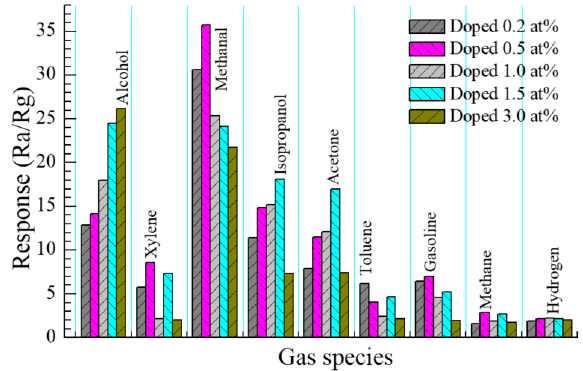
Figure 12. Response of gas sensor based on 0.5 at % Eu-doped SnO 2 nanorods arrays to various gases (200 ppm) including alcohol, xylene, methanal, isopropanol, acetone, toluene, gasoline, methane, and hydrogen at 278 °C.